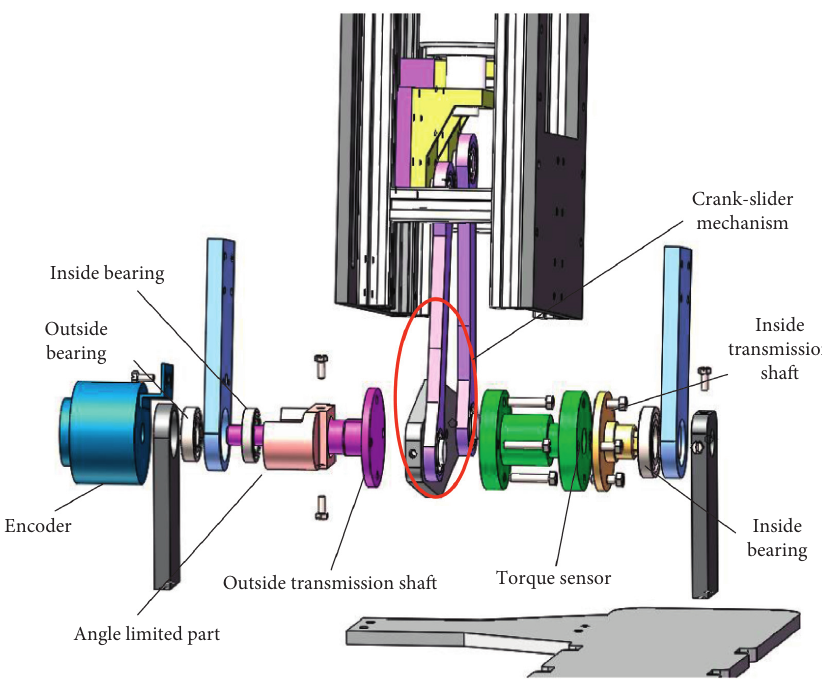
Figure 2: Decomposition diagram of the ankle joint mechanism.